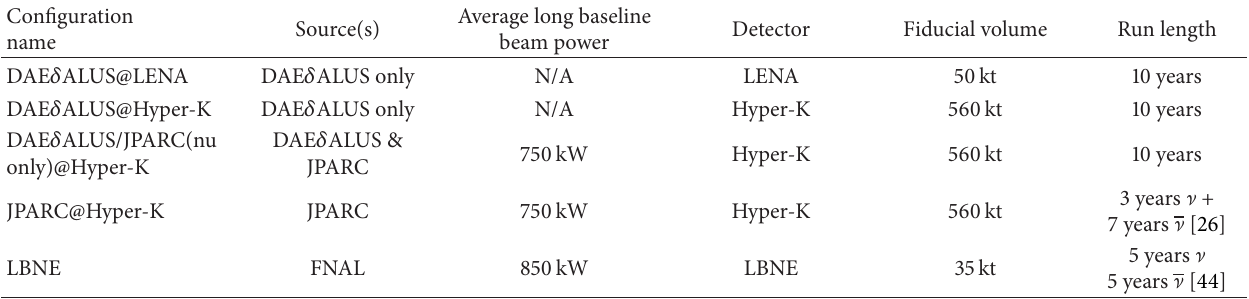
Table 5: Configurations considered in the various CP violation sensitivity studies.